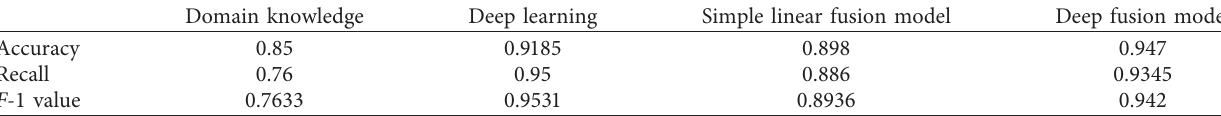
Table 7: Effect of each labeling method on labeling